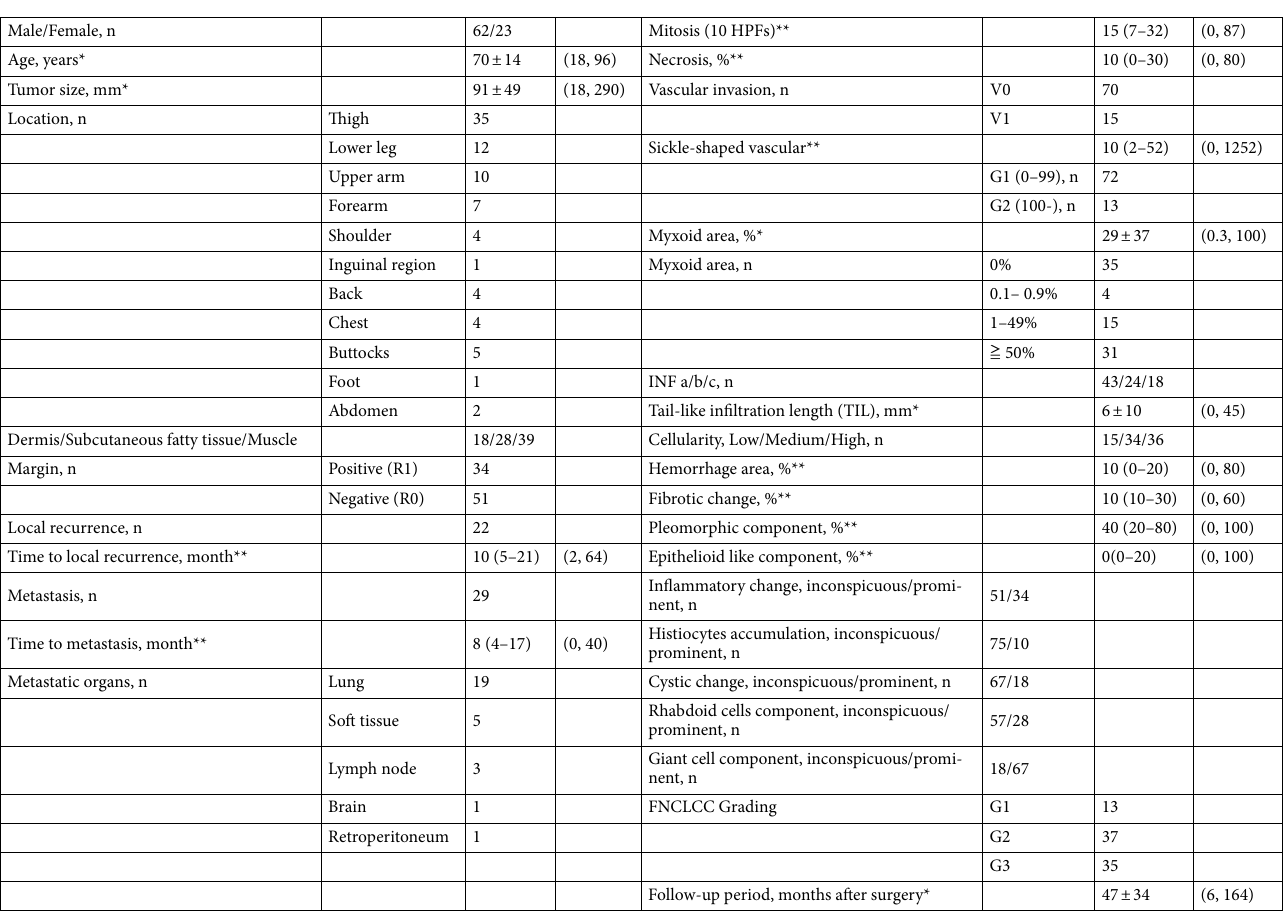
Table 1. Clinical and histological findings for 85 patients with myxofibrosarcoma/undifferentiated sarcoma. *Values are means ± SD (min, max). **Values are median (interquartile range). 1 HPF = 0.2374 mm 2